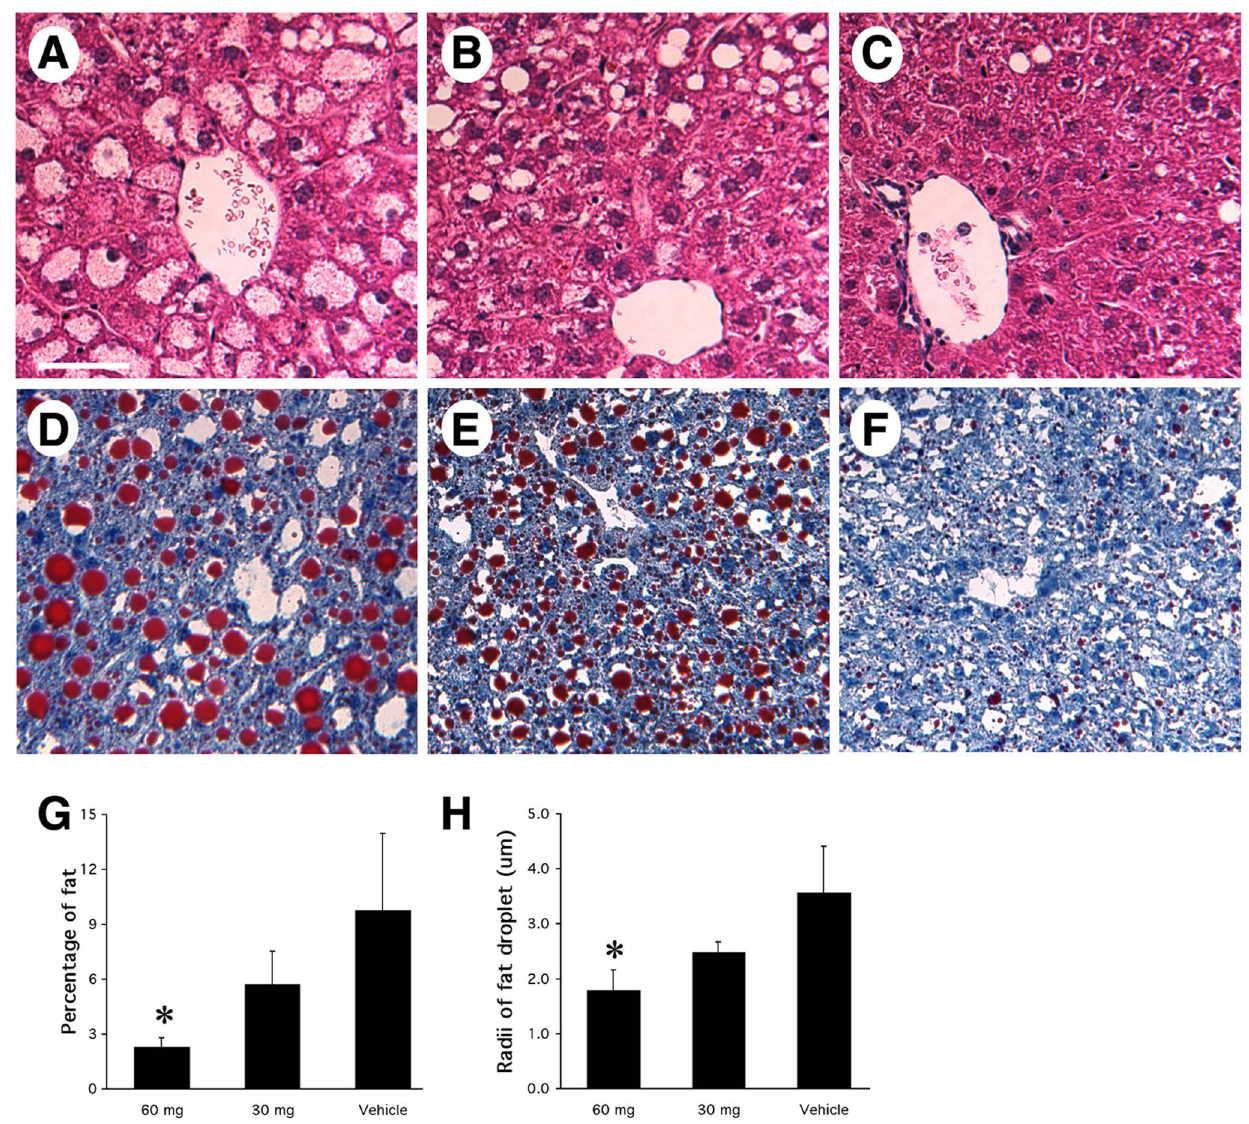
Figure 3. Histochemical analysis of ob/ob mouse livers with cerulenin treatment. Panels A–C : H&E staining. A. vehicle-treated ob/ob mouse liver, shows most hepatocytes had a big fat droplet (pale staining, representing the empty space left behind when the fat is removed during tissue processing), which occupied most space in the hepatocytes, while the nuclei was localized to the periphery. B . cerulenin-treated (60 mg/kg/day for 2 days) ob/ob mouse liver, shows significantly decreased number and size of fat droplets. In most hepatocytes, microsteatosis dominated. C. cerulenin- treated (60 mg/kg/day for 7 days) ob/ob mouse liver. Except for a few fat droplets, the overall appearance of the liver was almost to normal, especially in the areas close to the central vein. Panels D–F : Oil-Red-O staining of ob/ob mouse liver with 7 days of treatment; Red signals represent fat droplets. The treatment was: D . vehicle only; E. cerulenin-treated (60 mg/kg/day) for 2 days; F. cerulenin-treated (60 mg/kg/day) for 7 days. G : percentage of fat content in liver cross sections with 7-day treatment of either 60 or 30 mg/kg/day cerulenin. H : size of fat droplets in liver cross sections with 7-day treatment of either 60 or 30 mg/kg/day cerulenin. Scale bar: 60 m m. *: P , 0.05.